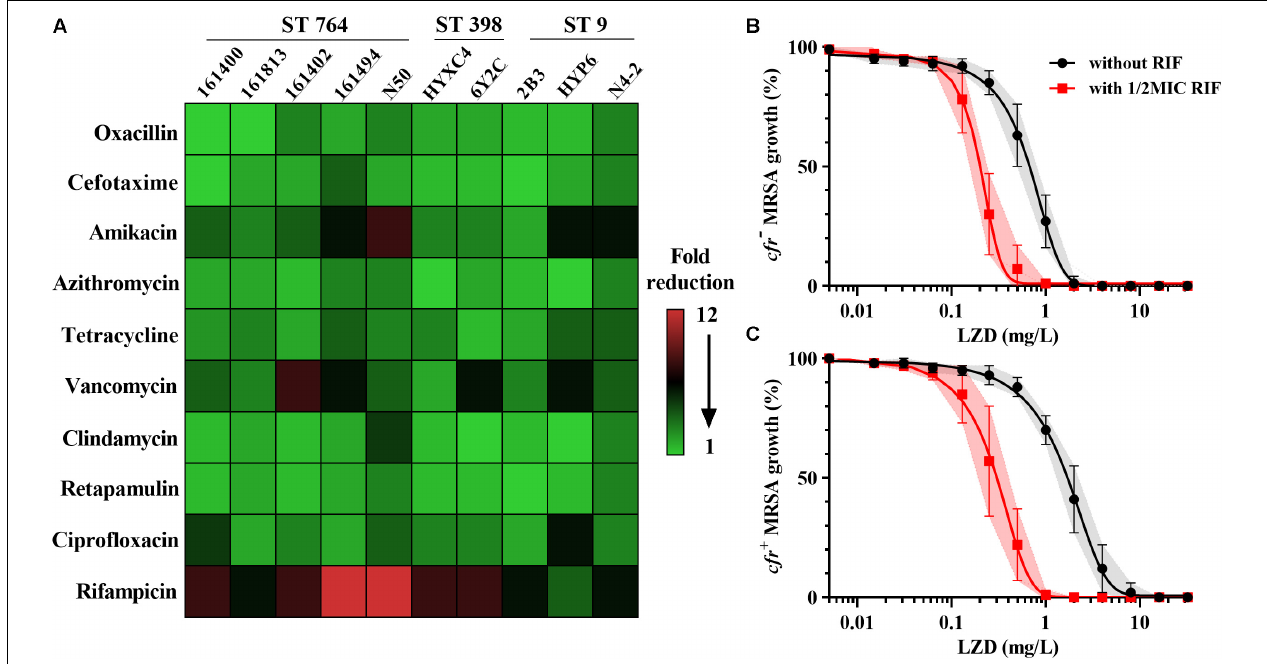
FIGURE 1 | Linezolid-based combination susceptibility testing and potency analysis. (A) Heat map showing the mean fold reduction of MIC in the presence of 0.5 mg/L linezolid for MRSA strains. The strains carrying the cfr gene are underlined; Concentration-effect analysis of linezolid against cfr -negative (B) and cfr -positive (C) MRSA strains in the presence (red) and absence (black) of 0.5 × MIC rifampicin. Data were shown as mean with 95% CIs from three biological replicates.